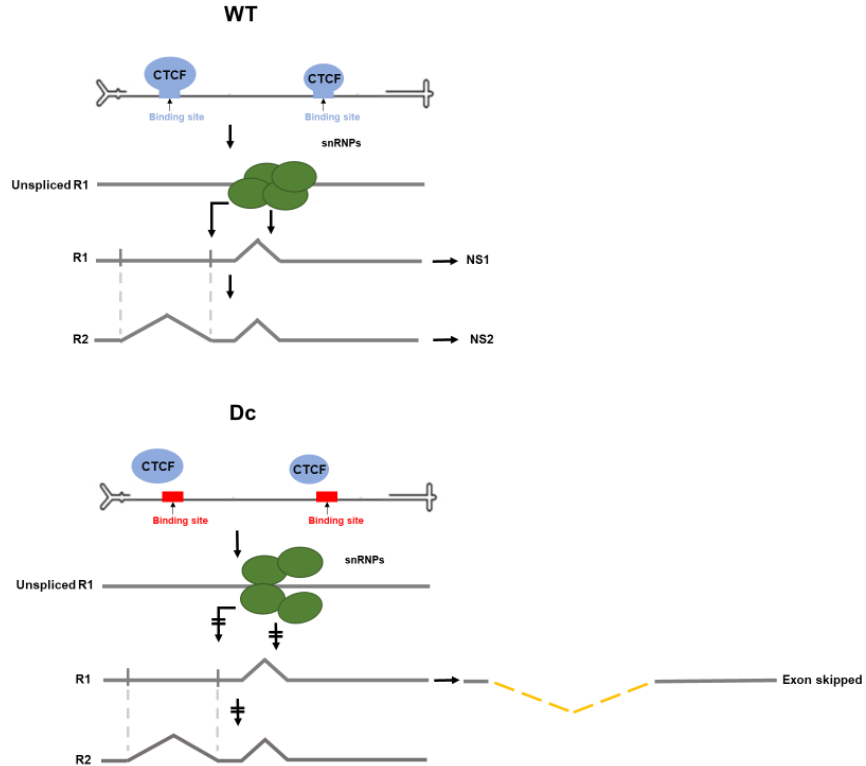
Figure 5. Model depicting a potential mechanism by which CTCF regulates splicing of MVM P4-generated transcripts. Top: A general model of processing of P4-generated pre-mRNAs; CTCF binding to the viral genome likely plays a role in proper engagement of the spliceosome at the small intron, allowing its splicing as well as facilitating its interaction with the upstream large intron acceptor, to define the NS2-specific exon allowing splicing of the large intron. Bottom: In the absence of CTCF binding, R1 would be poorly spliced, and the NS2-specific exon poorly defined, leading to the generation of a novel exon-skipped product.